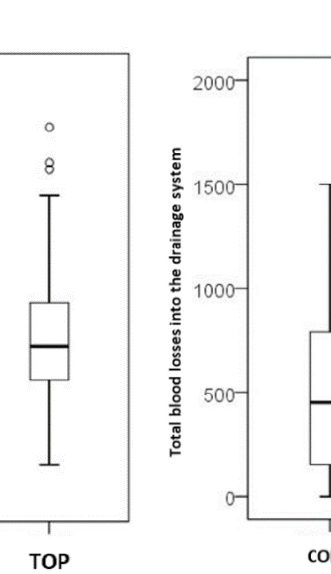
Fig. 3. An illustration of the range of blood loss to drainage systems in each